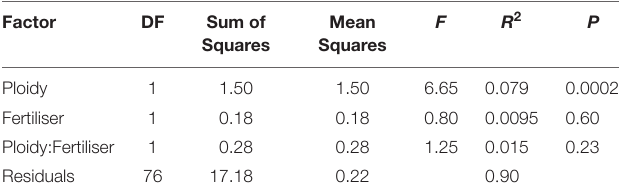
TABLE 3 | PERMANOVA results for the 21 floral volatiles emitted by Chamerion angustifolium individuals, testing for the effects of ploidy, fertiliser during growth, and their